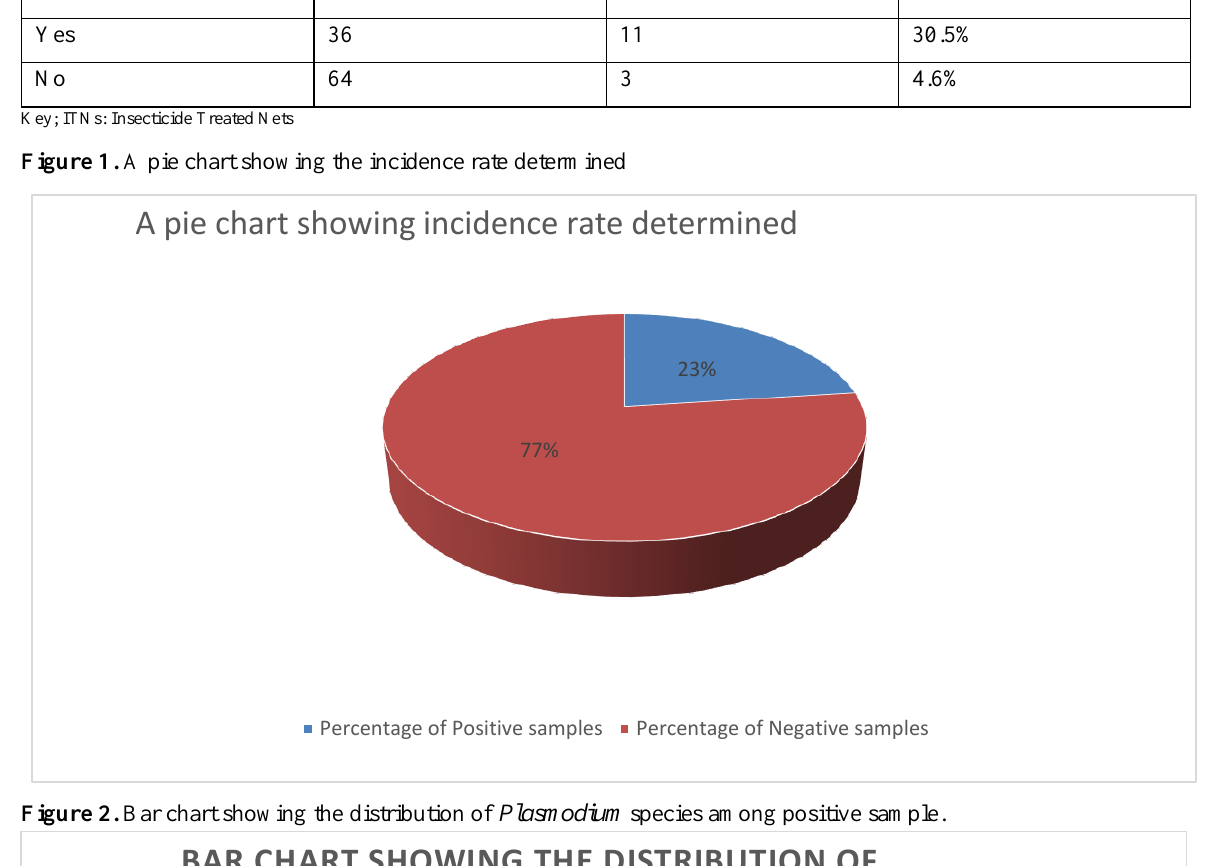
Table 2. The incidence rate in relation to patient response to the use of ITNs from the structured questionnaire. Factors